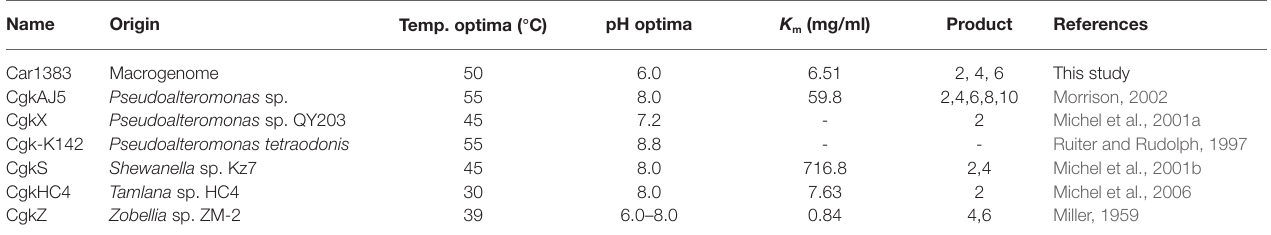
TABLE 2 | Biochemical characteristics of reported κ